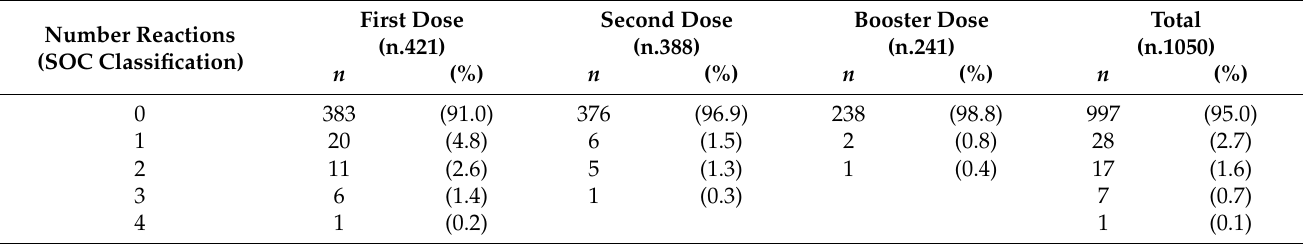
Table 1. Distribution of number of reactions (SOC classification) vs. doses